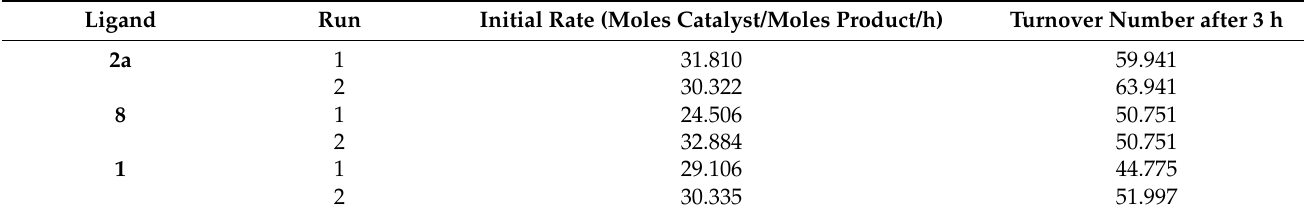
Table 1. First catalysis trials for methyl propanoate formation from ethene, CO, and methanol using palladium(II) complexes of bidentate phosphane ligands ( 1 , 2a , and 8 ).